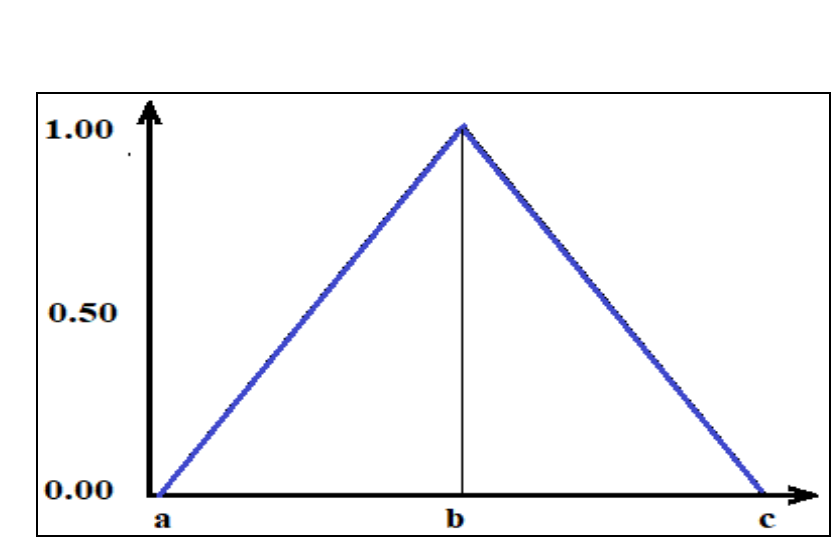
Figure 2. Triangular fuzzy number 𝝉